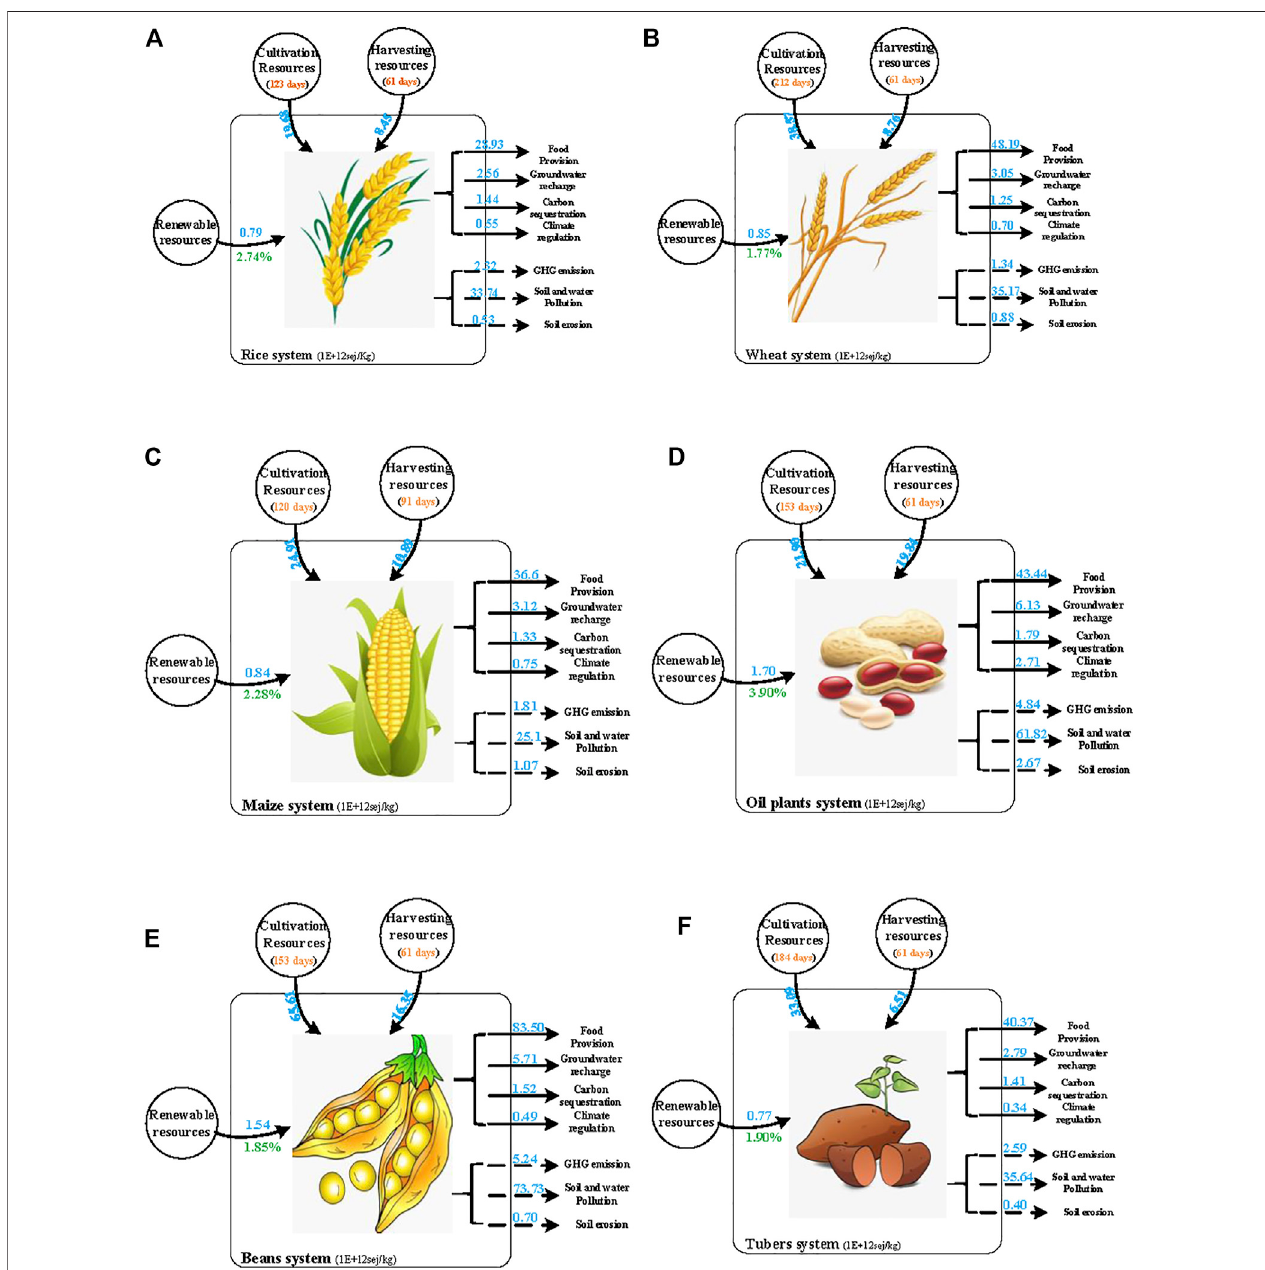
FIGURE3 | Ecosystem services(ES) and dis-services (EDS) diagrams for aset oftypical Chinesecrops: (A) rice; (B) wheat; (C) maize; (D) oil plants; (E) beans; (F) tubers.